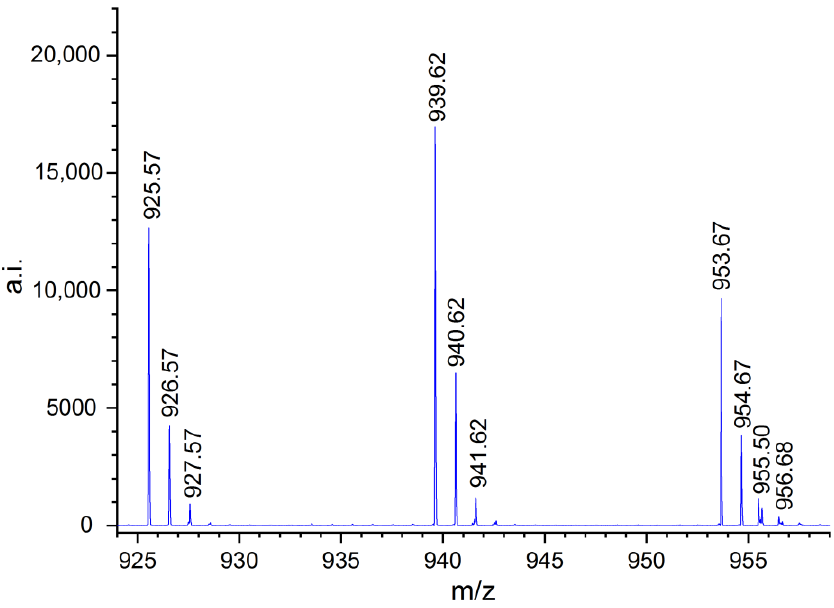
Figure 6. Expansion of the MALDI-TOF MS spectrum in the range m/z = 924–959. Figure 7 presents a higher molecular weight region of the spectrum. Peaks for HO-(CH 2 ) 6 -O-(C 3 H 6 O) 24 (CO 2 ) 2 HNa at m MI /z = 1622.06 and others separated from it by about m/z = 1.00, share this spectrum area with peaks corresponding to HO-(CH 2 ) 6 -O-(C 3 H 6 O) 21 (CO 2 ) 6 HNa (1623.89, 1624.89, 1625.89, 1626.90 and 1627.90). The peaks at 1621.95 and 1622.96 correspond, most probably, to allyl (or propenyl) terminated polymer chains, e.g., CH 2 CHCH 2 O(C 3 H 6 O) 21 (CO 2 ) 6 HNa.